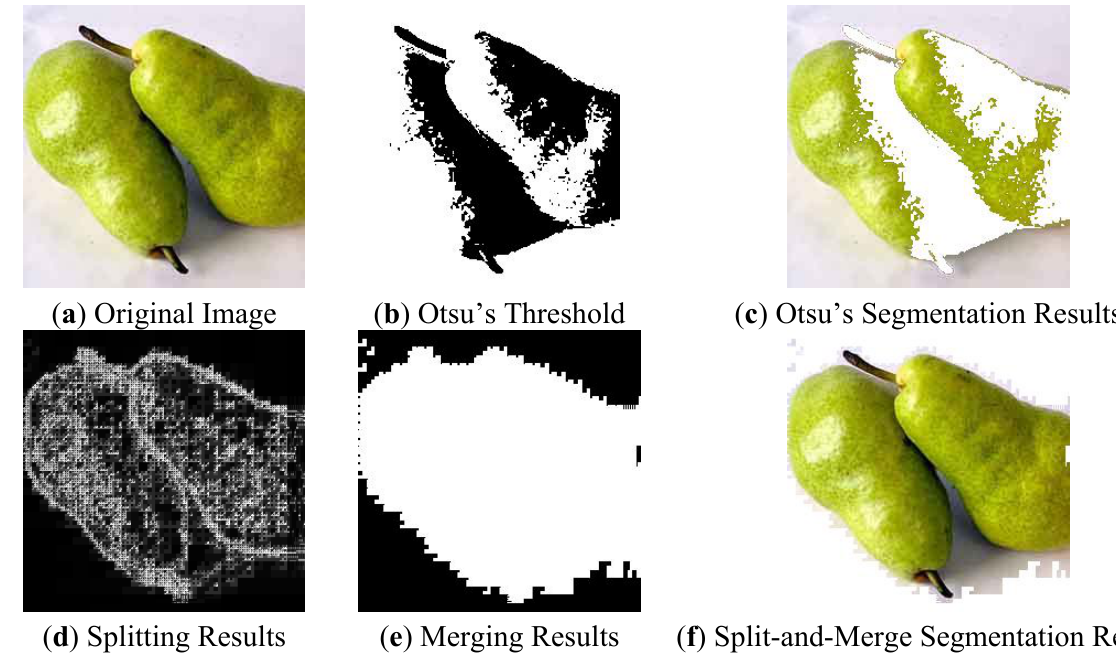
Figure 1. Comparison of Otsu’s Method with split-and-merge